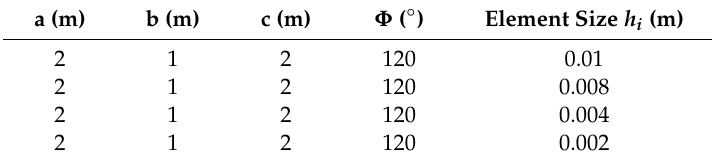
Table 6. Computation time at di ff erent surface lengths and heights for Φ = 120 ◦ and h i = 0.01